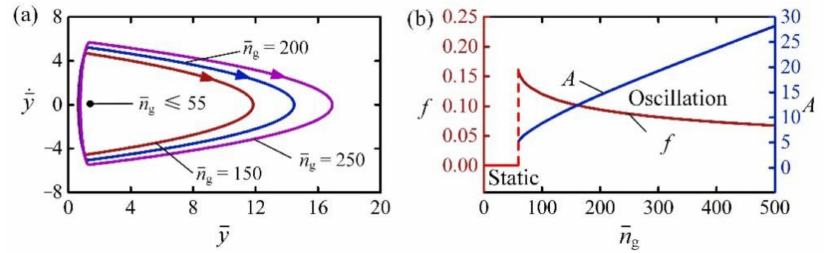
Figure 11. The effect of amount of substance on the self-jumping for I 0 = 2, C 0 = 0.3, H = 4, β = 0.01, . = 0.5, E = 500, y = 30, and = 0. ( a ) Limit cycles. ( b ) Frequency and amplitude. With g = 1, p y am 0 0